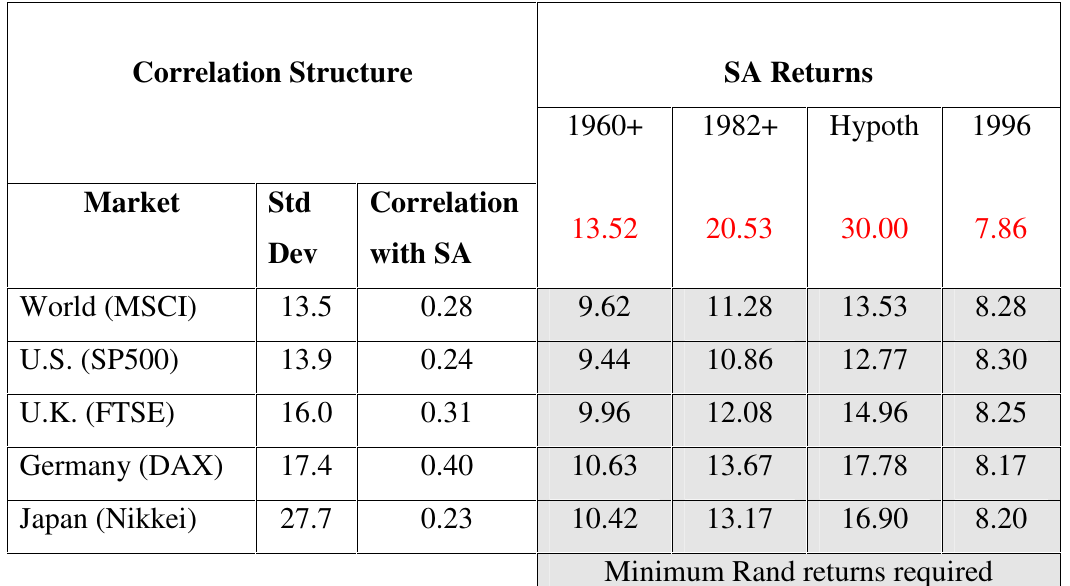
Table 2. Minimum Rand returns required for diversification benefits The foreign Rand return R has two components, a home return X and a foreign exchange